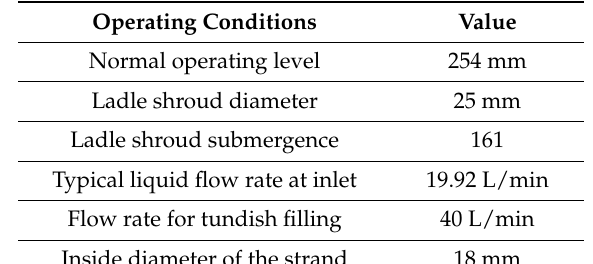
Figure 2. Dimensions of the tundish in millimeters at 1/3 scale of the actual one.